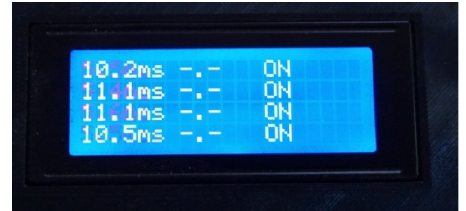
Figure 8. Fuel injection time control on the display of the DBD-4 device The ionization voltage of the spark plugs was cont– rolled using a USB-Autoscope III Postolovsky oscillo– scope. The device has high universal applicability for various car brands.